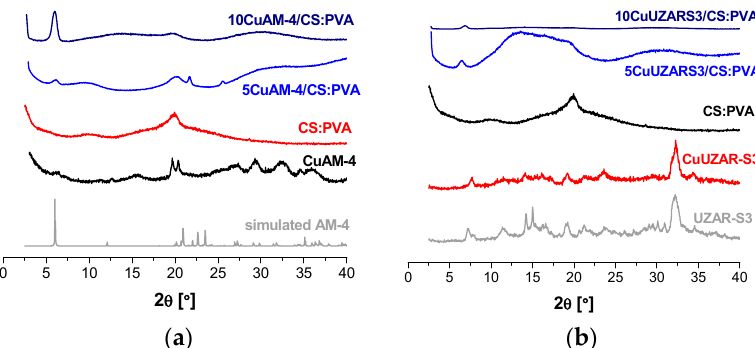
Figure 1. XRD diffractograms of layered CuAM-4 titanosilicate-filled ( a ) and CuUZAR-S3 stannosilicate filled ( b ) CS:PVA mixed matrix membranes.